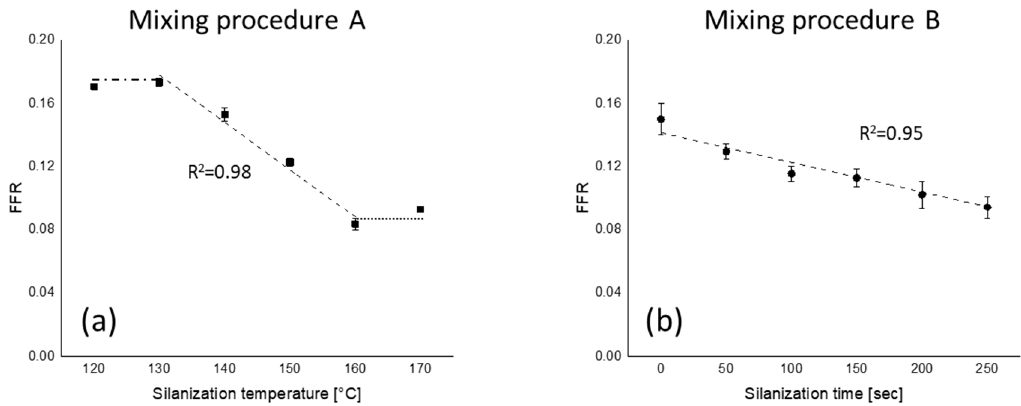
Figure 6. Filler flocculation rate (FFR) as a function of ( a ) silanization temperature and ( b ) silanization